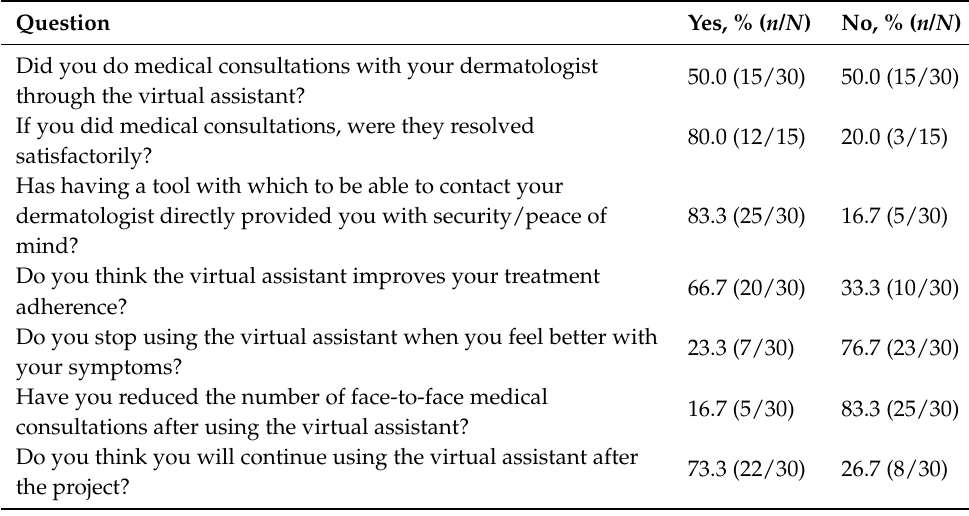
Table 6. Patients’ responses regarding general use and perception of the virtual